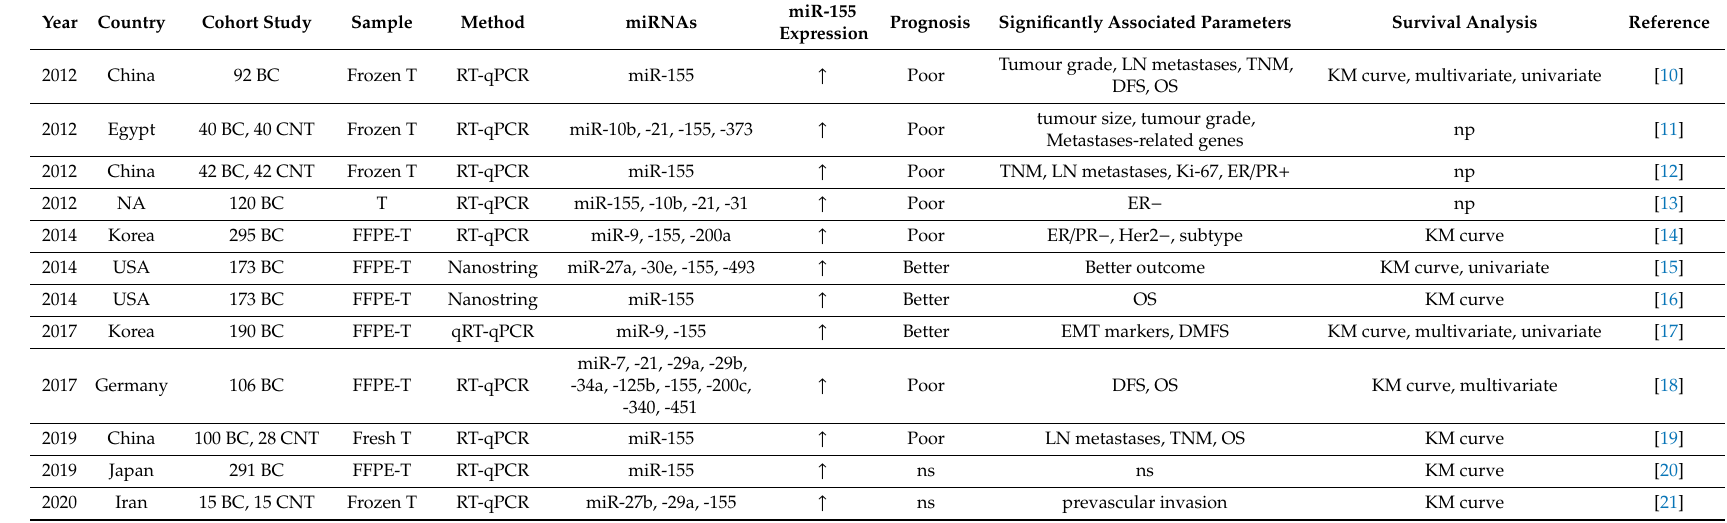
Table 1. Comprehensive characteristics of selected studies and association between tissue miR-155 and prognostic characteristics in breast cancer